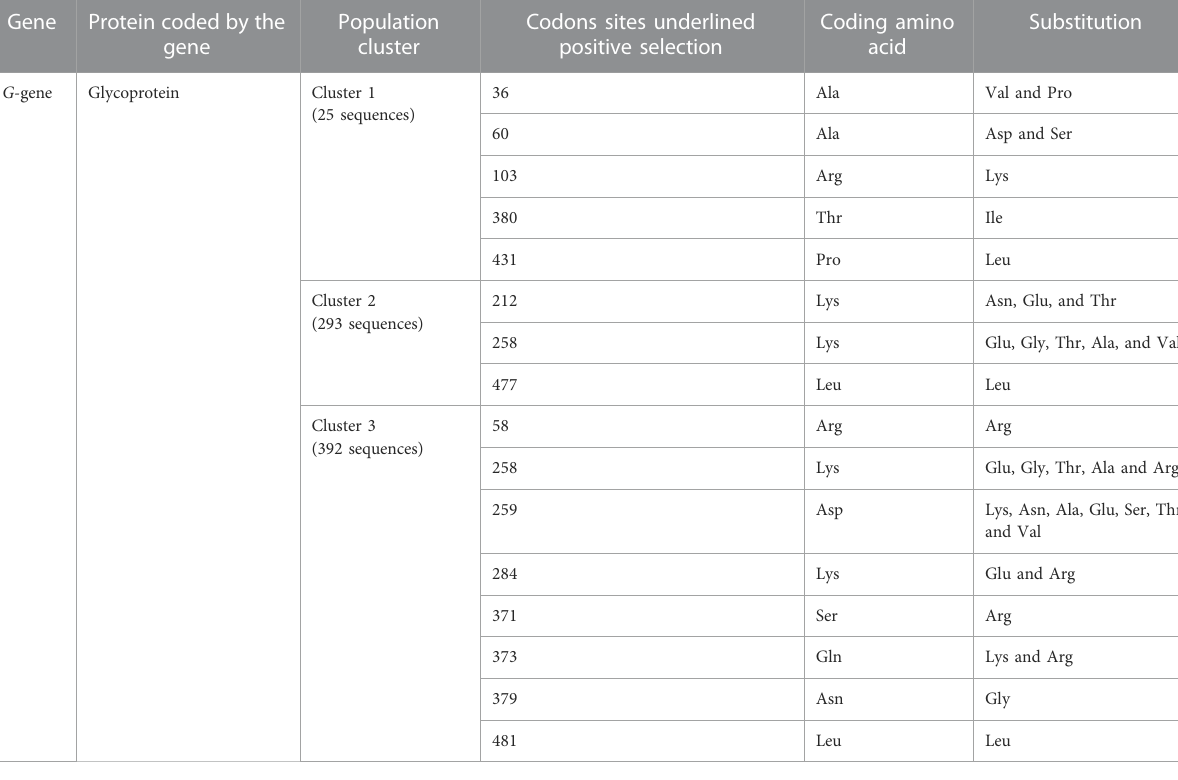
TABLE 3 MEME method-based episodic selection sites in VHSV G -gene among the three subpopulation clusters. Gene Protein coded by the gene